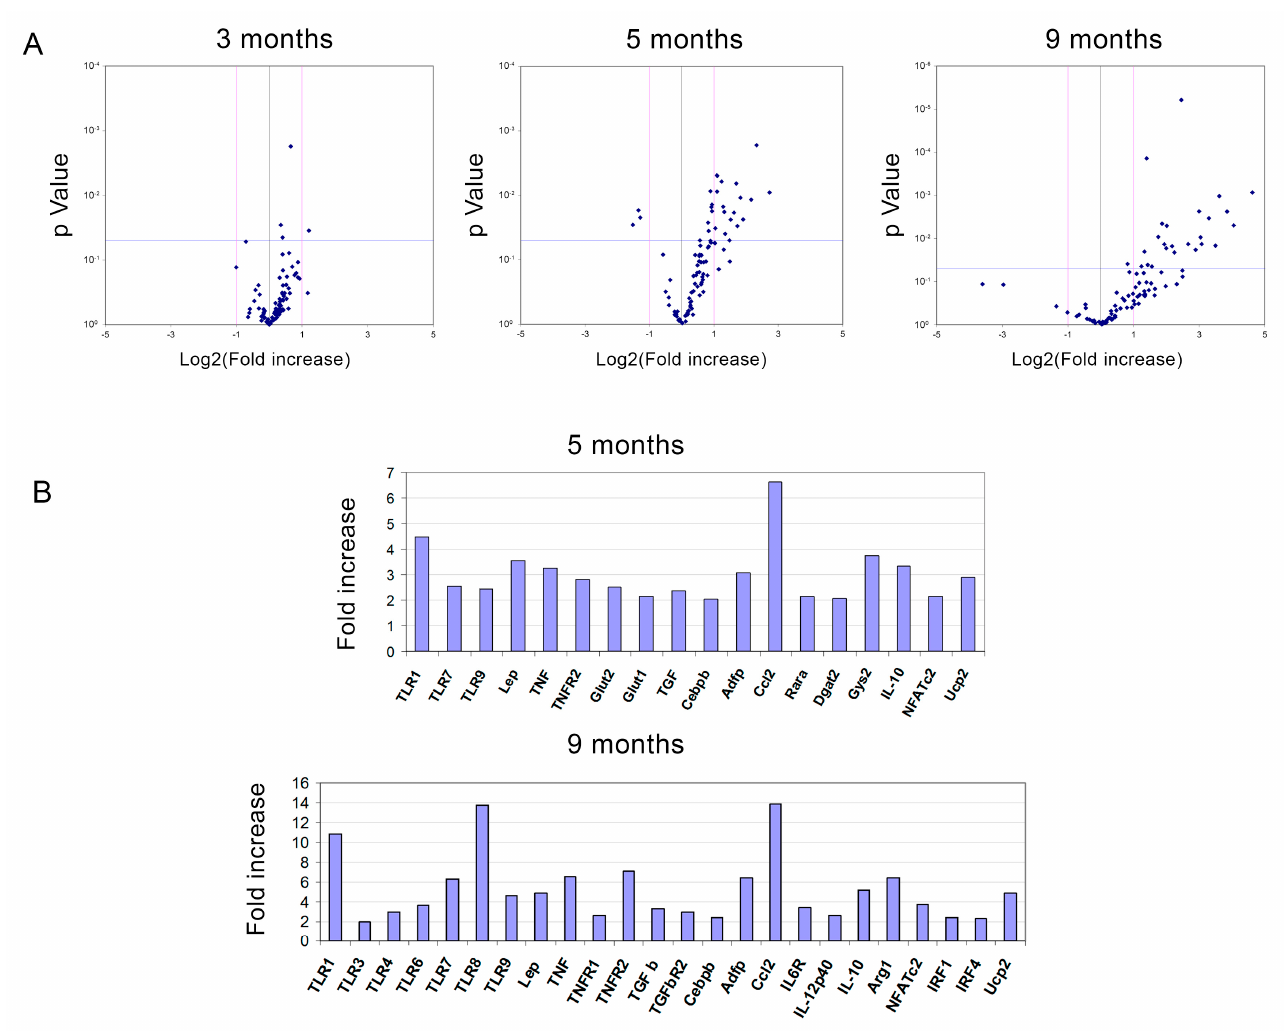
Figure 5. Loss of TLR2 correlates with an increase in mRNA gene expression of adipogenesis-related genes in WAT. ( A ) Volcano plots of gene expression data in epididymal WAT comparing P values versus fold change plotted for TLR2 − / − vs. WT mice at 3, 5, and 9 months of age. ( B ) Bar graphs showing the significantly up-regulated genes in the WAT of TLR2 − / − mice at 5 and 9 months of age. The genes were detected by real-time PCR in microfluidic